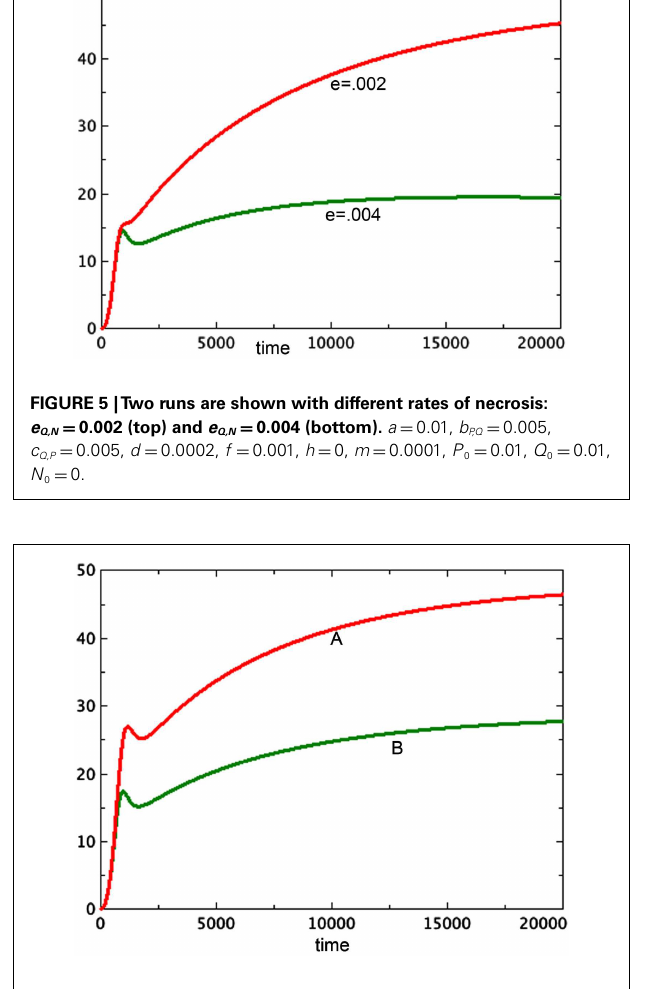
FIGURE 6 | Here we see two graphs of total tumor size. The larger, A, is a single spheroid in isolation.The smaller, B, is two graphs superimposed of identical spheroids grown together as in Figure 5 , where the necrosis factor of both spheroids affects each system. a = 0.01, b P,Q = 0.005, c Q,P = 0.005, d = 0.0002, e Q,N = 0.002, f = 0.001, h = 0, m = 0.0001, P 0 = 0.01, Q 0 = 0.01, N 0 = 0.